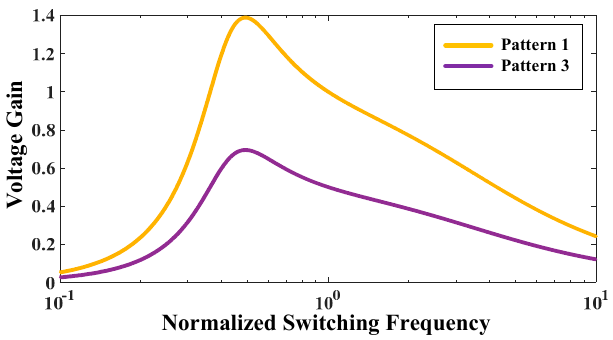
Figure 7. Voltage gain curves of Switching Patterns 1 and 3.